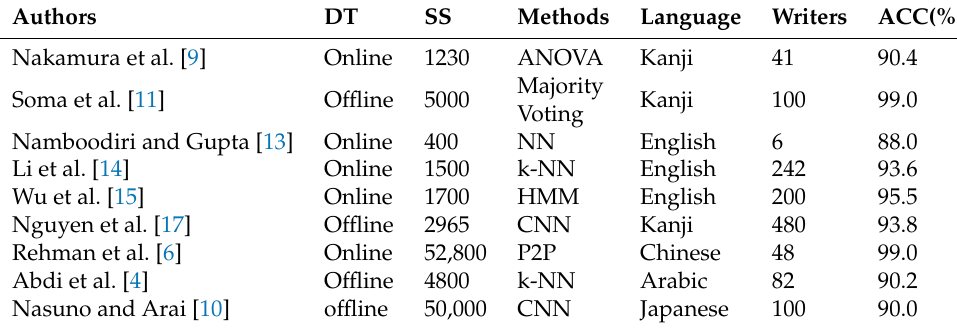
Table 1. Previous research on writer